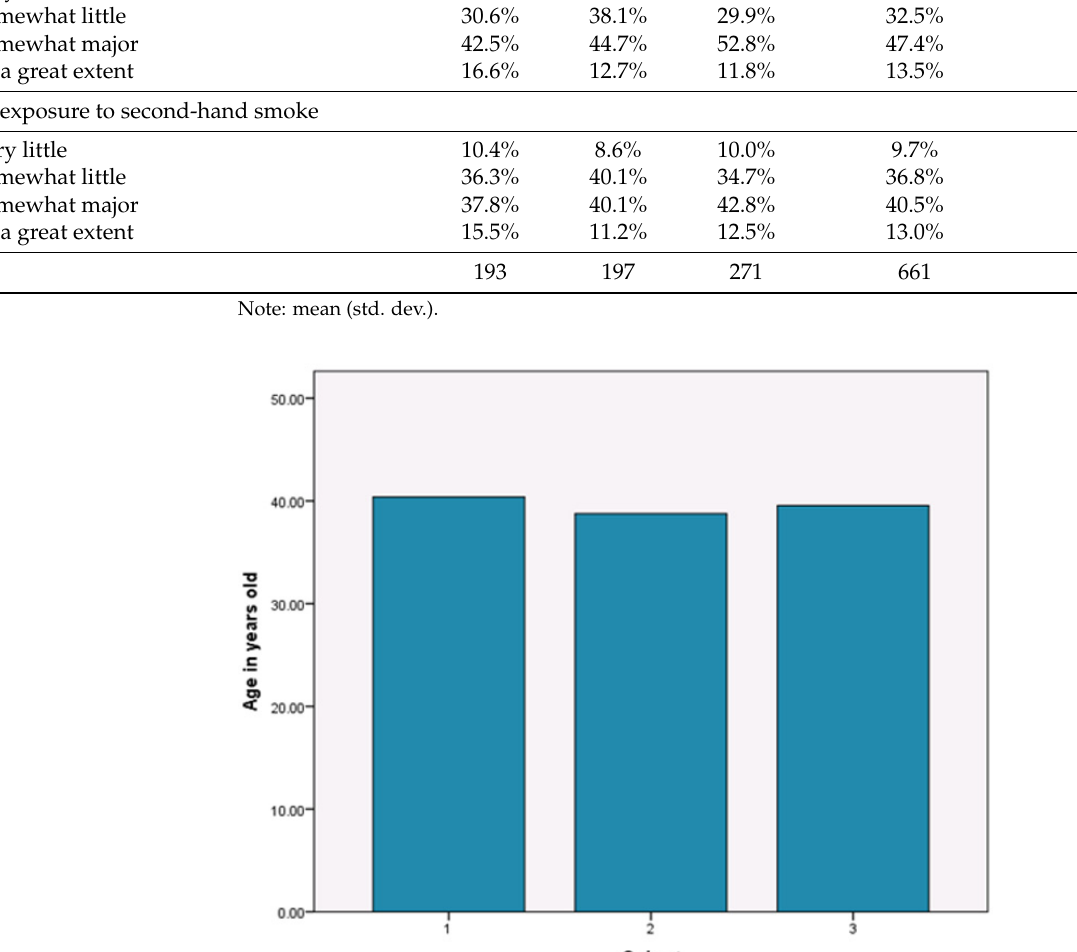
Figure 2. Randomness of Gender Distribution.